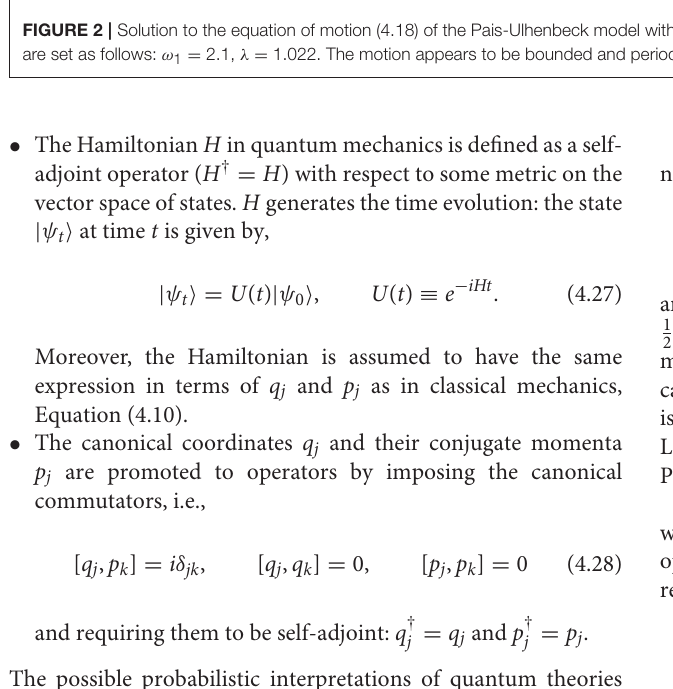
λ sin ( q ) 4 . The plot is presented in units of ω 2 . The other parameters =